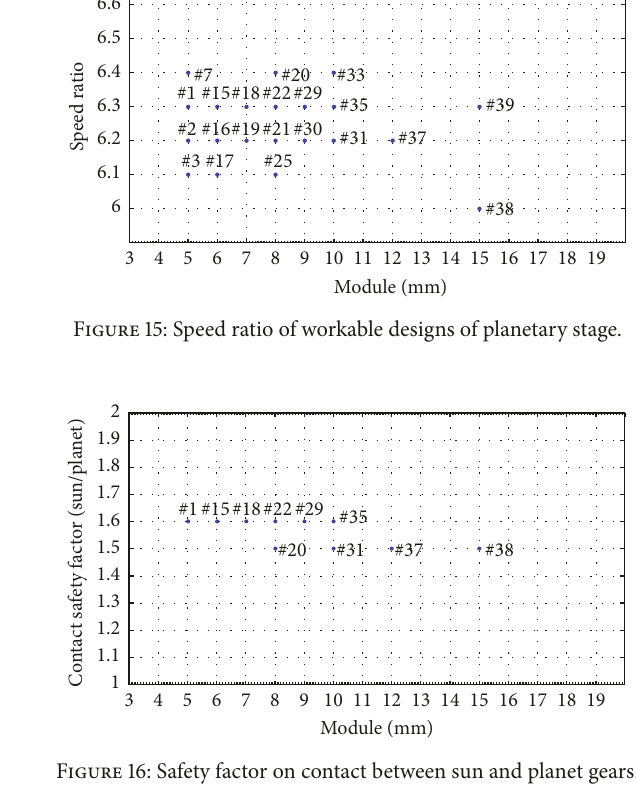
Figure 14: Center distance of workable designs of planetary stage.